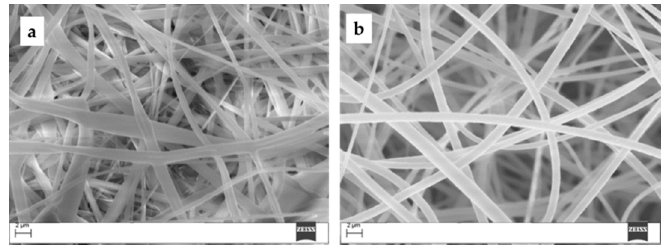
Figure 2. SEM images of polyethersulfone (PES) mats ( a ) before and ( b ) after dipping in a 5 μ M H 2 TPP solution in toluene.